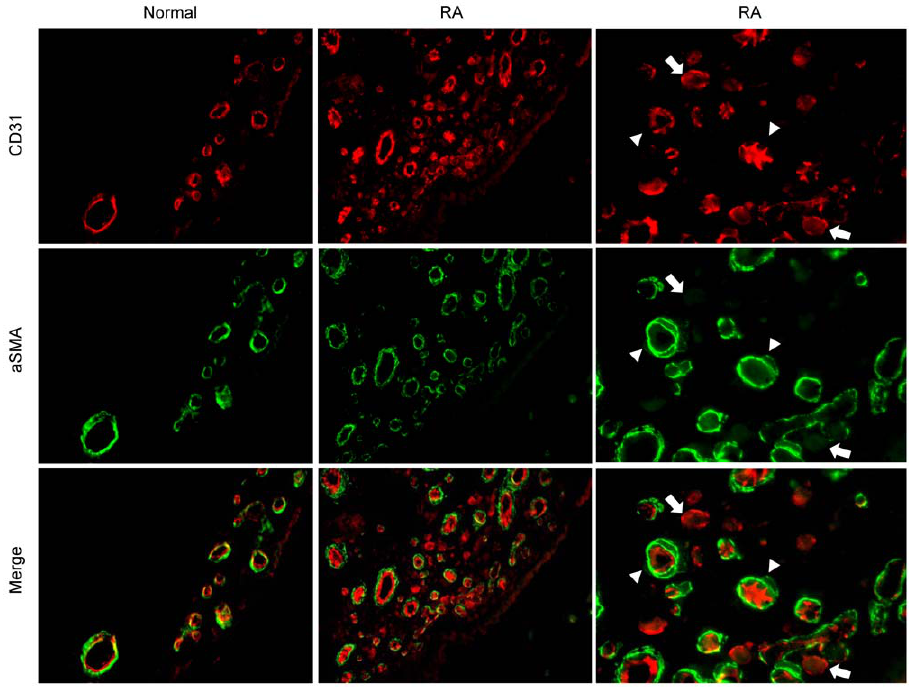
Figure 1. Detection of immature or mature blood vessels in RA synovial tissues. Double immunoflurescent labeling of endothelium (CD31, red fluorescence) and pericytes/smooth muscle cells (aSMA, green fluorescence) in normal and RA synovial tissue is shown. Original magnification 6 400. Right panels show the same area as in middle panels with higher magnification. Mature CD31 + vessels covered by aSMA + periendothelial cells are marked by arrows, and immature CD31 + vessels lacking aSMA + mural cells by arrow heads.